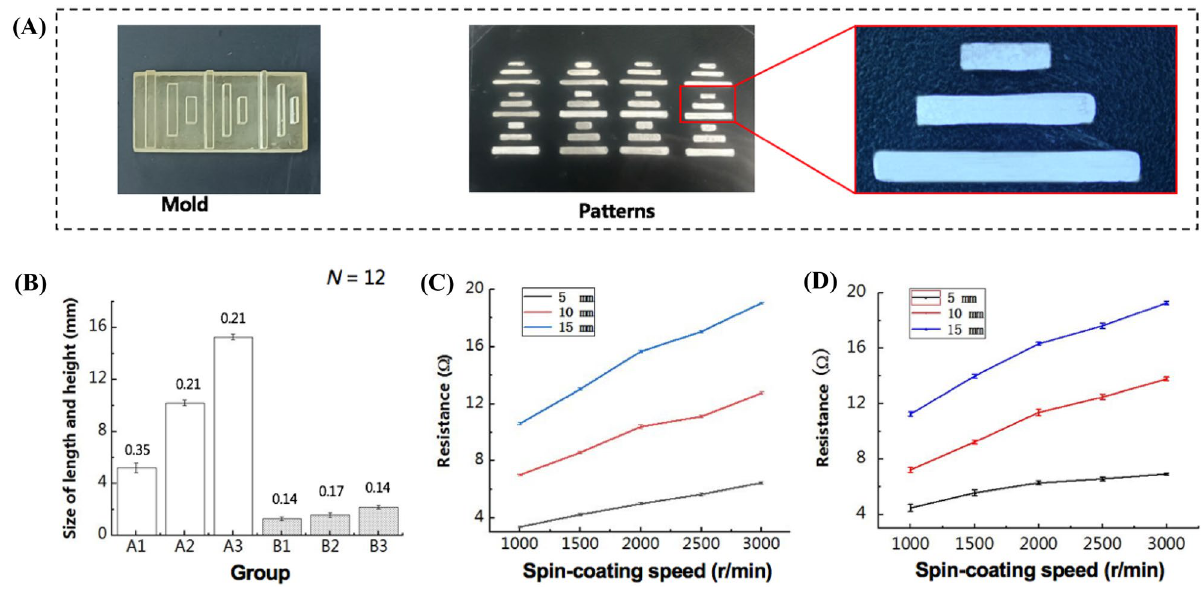
Figure 3. Resolution tests of the transfer printed electrodes. (A) Photographs of electrode molds by a light curing printer and the printed electrode patterns with the molds. (B) The length and width resolution test results of the patterned electrodes. The coefficients of variation for patterned electrodes with length of 5, 10, 15 mm (A1–A3) were 10.9%, 10.8% and 6.5%, respectively, and the coefficients of variation for patterned electrodes with width of 1.0, 1.5, 2.0 mm (B1–B3) were 6.7%%, 2.1% and 1.4%, respectively. The numbers above the histograms refer to the standard deviations. (C) Relationship between the resistance of printed electrodes on silicon with different spin-coating speeds ( N = 4). (D) Relationship between the resistance of printed electrodes on PDMS with different spin-coating speeds ( N =